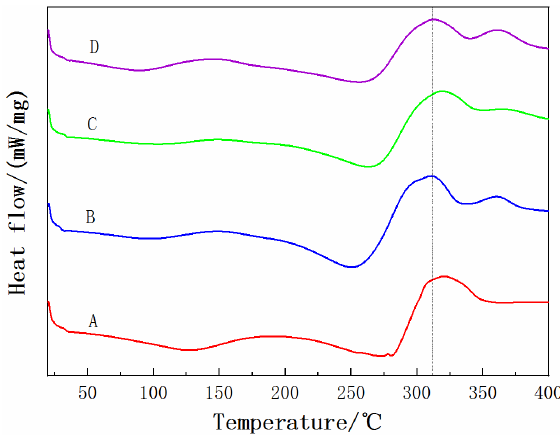
Figure 5. DSC thermograms of CMC film, and blended CMC-CFEO films with various concentrations of CFEO. A: Control film (CMC); B: CMC + 1% CFEO film; C: CMC + 2% CFEO film; D: CMC + 3% CFEO film.